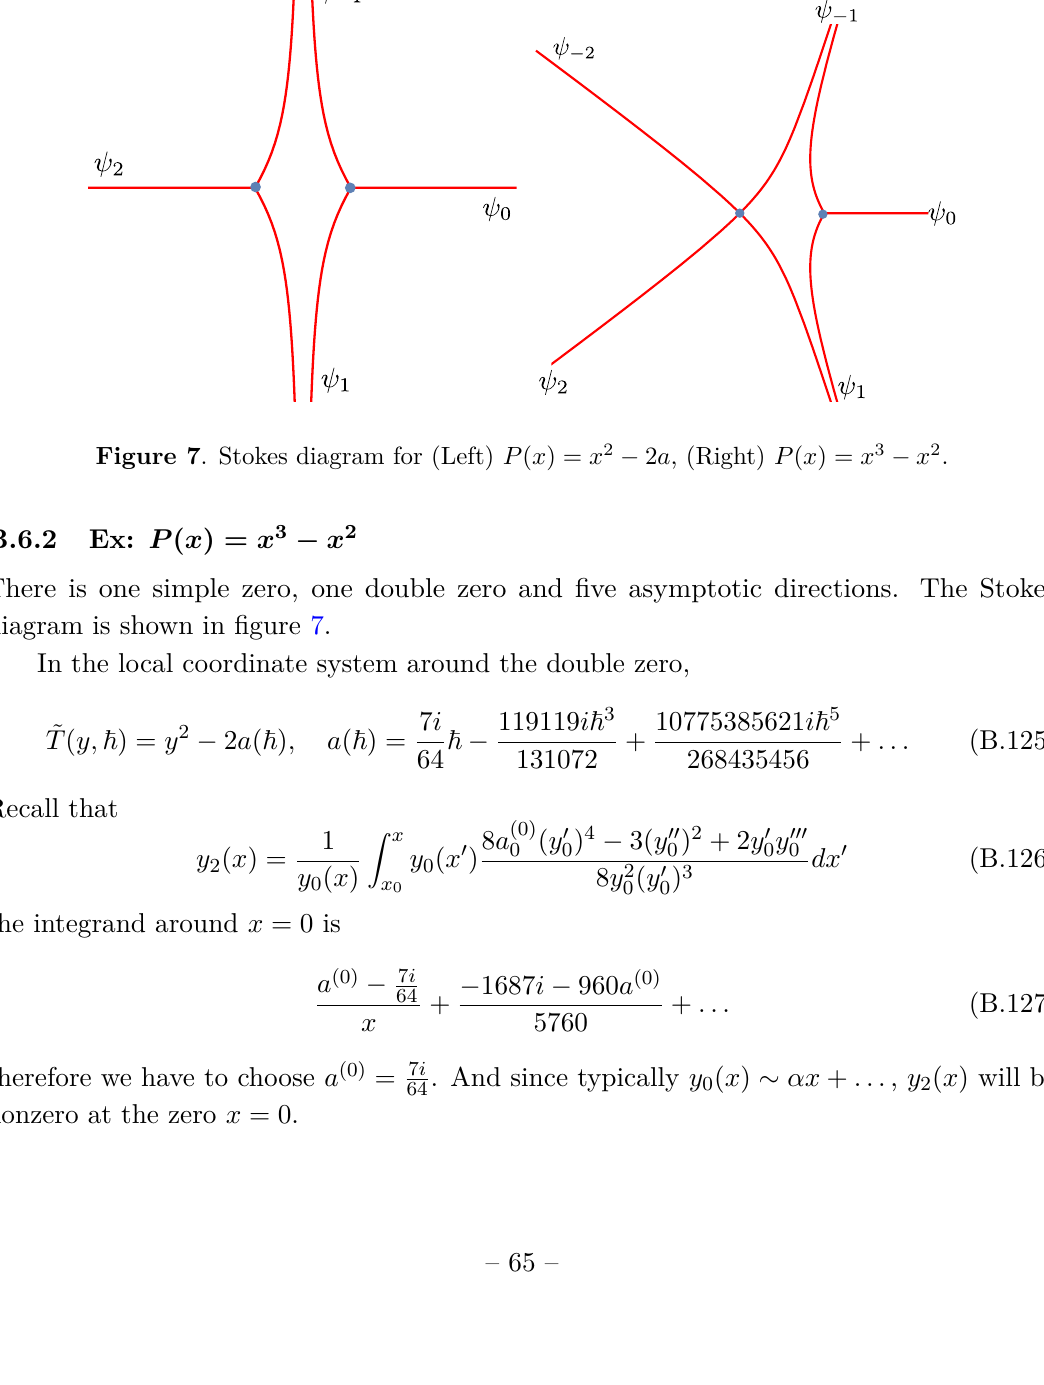
Figure 6 . Numerical error ∆ error ≡ ∂ P ( x ) = x 3 − x 2 and ~ = 1 . This is just to illustrate numerical error is indeed very small.